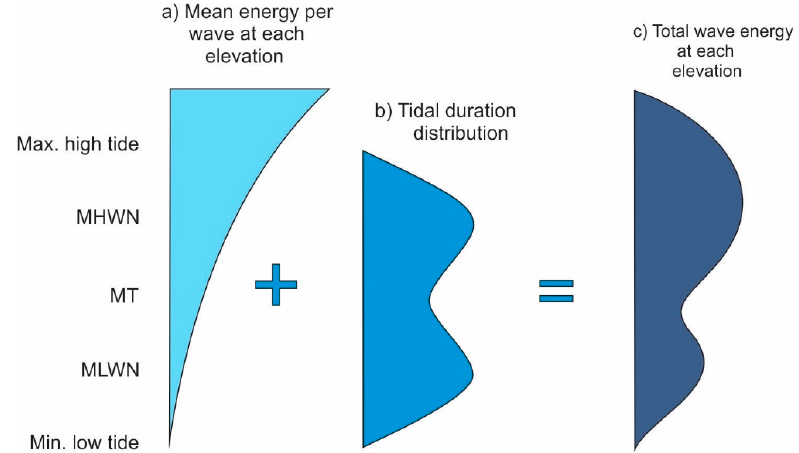
Figure 3. ( c ) Conjectural representation of wave energy expenditure within the intertidal and supratial zone as a function of: ( b ) The tidal duration distribution (wave frequency at each elevation); and ( a ) the effect of tidal modulation and storm surges on individual wave energy and elevation. MHWN, MT, and MLWN refer to mean high water neap, mid-tide, and mean low water neap tidal levels, respectively.